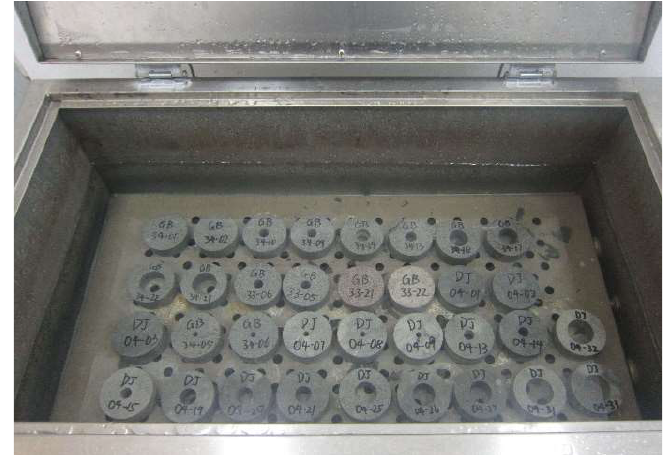
Figure 2. Water bath box.